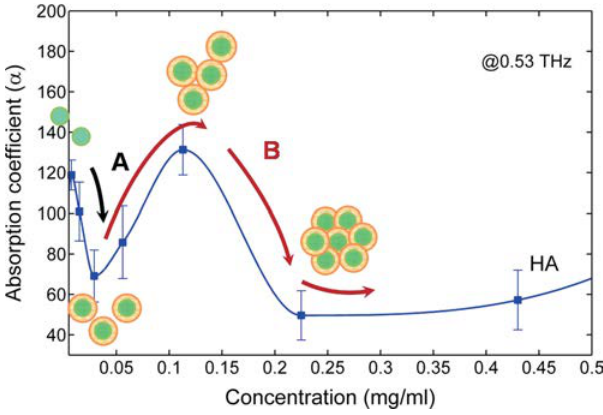
Fig. 6. Schematic diagram for overlap of the hydration shells to interpret the nonlinear absorption behaviors depends on the HA concentration using a binary component model (A) and a ternary component model